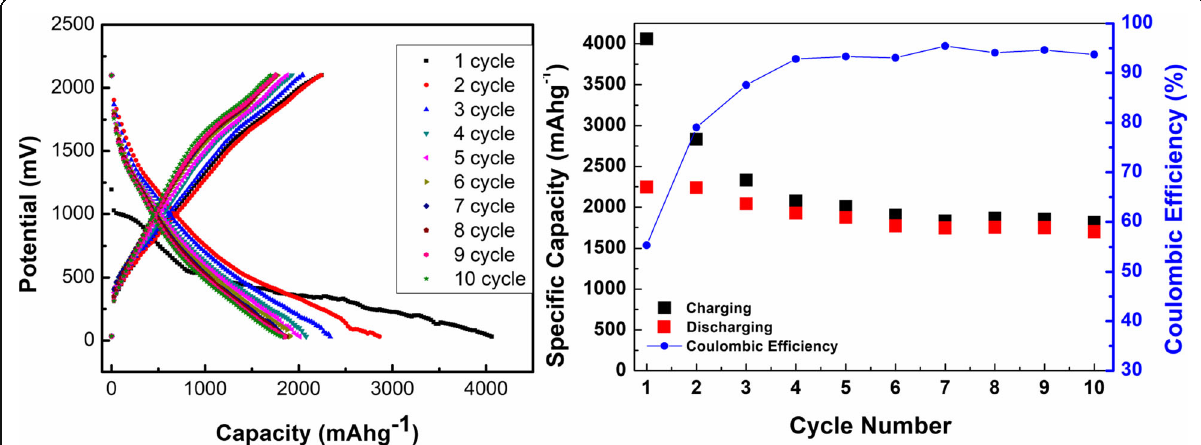
Fig. 3 a Charge discharge curves for 10 cycles (left) and b coulombic efficiency and specific capacity vs cycle number